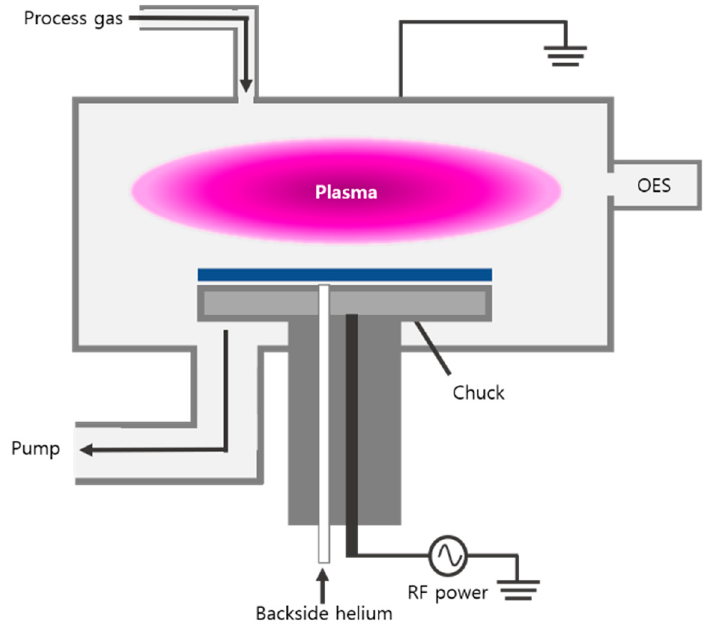
Figure 1. Schematic of the ICP etcher.